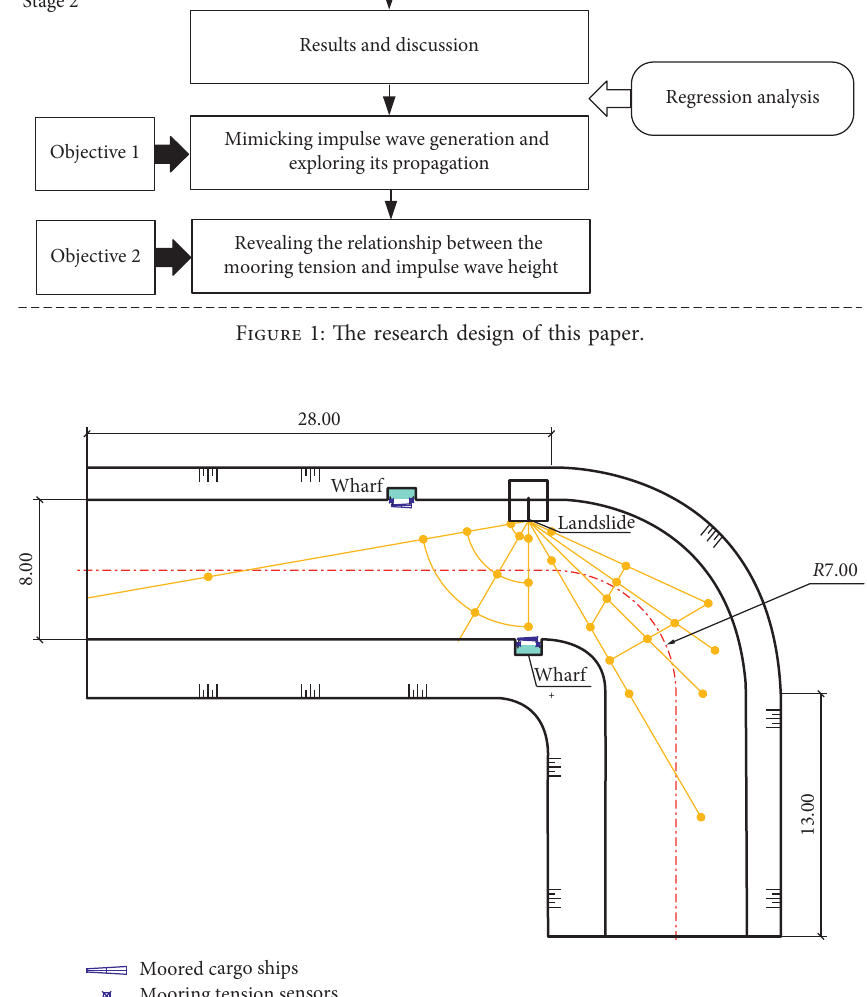
Figure 2: Schematic diagram of model experimental layout; geometrical measurements were in m.